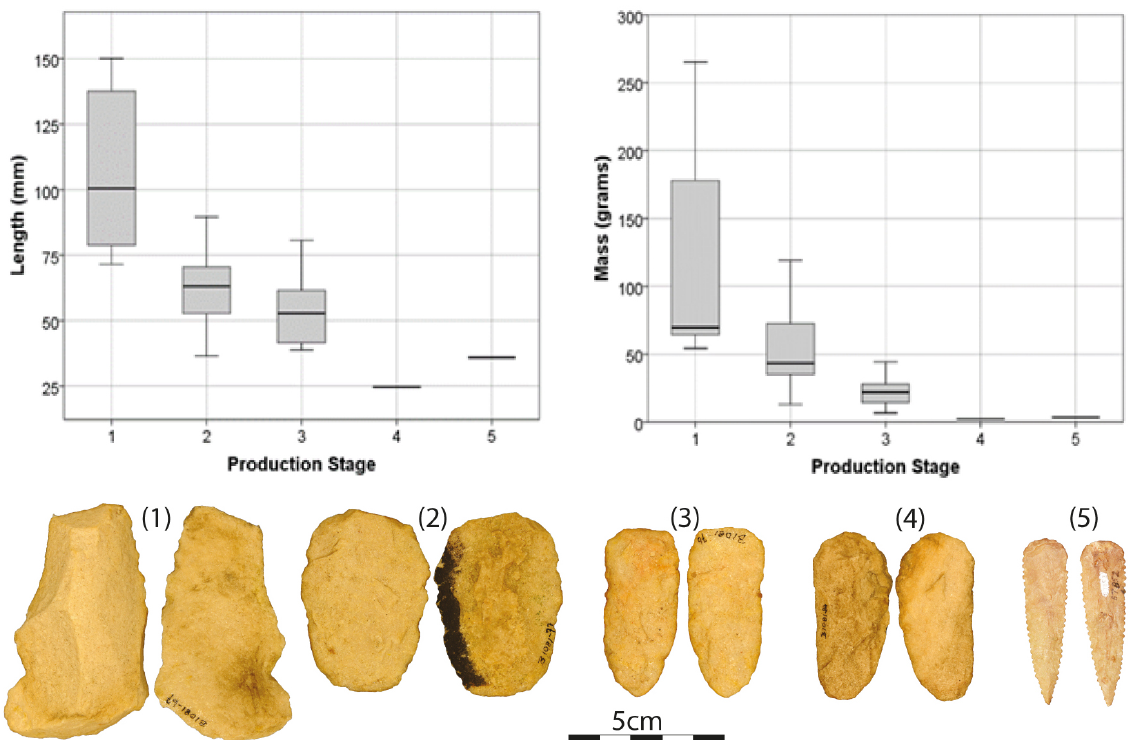
Figure 12. Decreasing biface length and mass, according to production phase. Examples of production phases from the Mandanari sample.